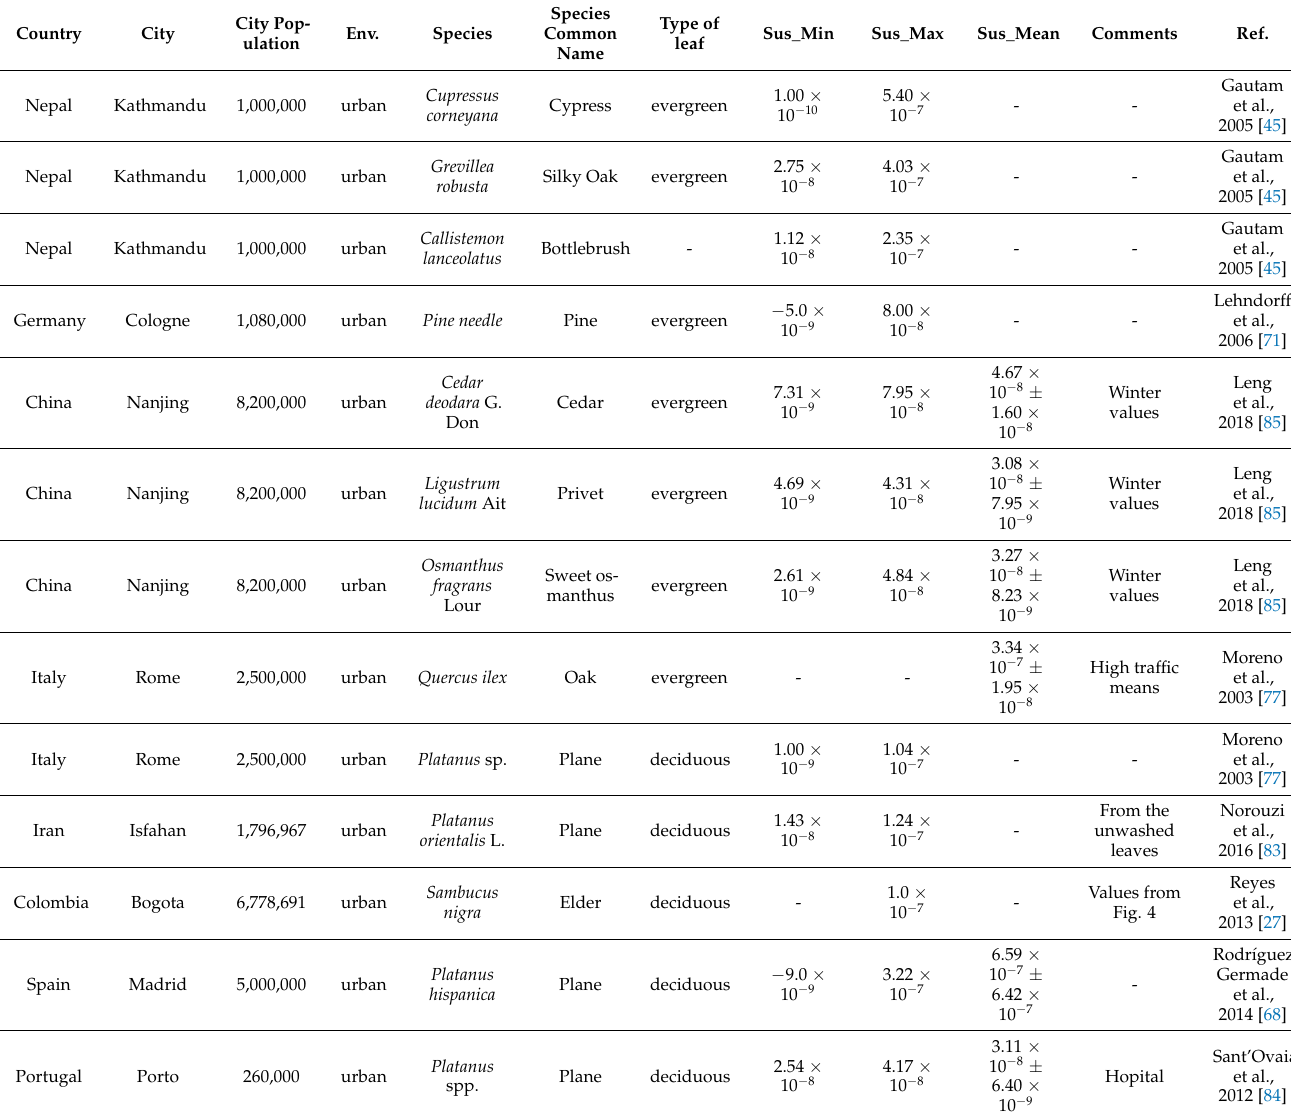
Table 1. Magnetic susceptibility values (in m 3 kg − 1 ) obtained on leaves in different cities. Env. is environment, Sus_min is the minimum magnetic susceptibility values, Sus_max is the minimum magnetic susceptibility values, Sus_mean is the mean magnetic susceptibility and Ref. is the